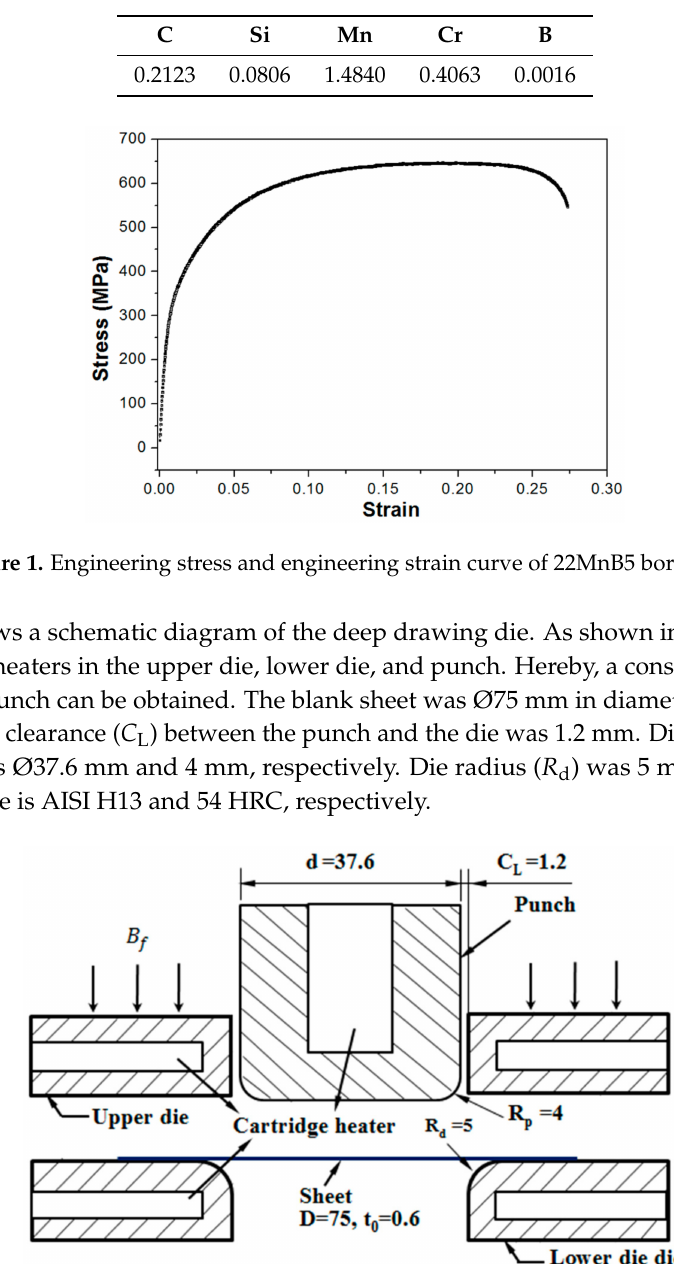
Table 1. Chemical composition of 22MnB5 boron steel (wt %).